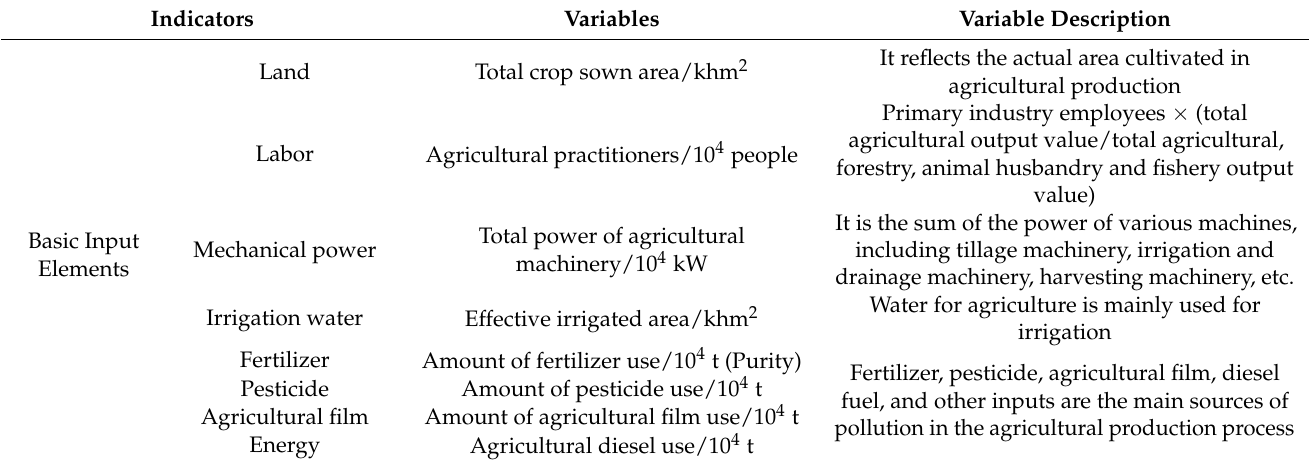
Table 1. APE index system under dual